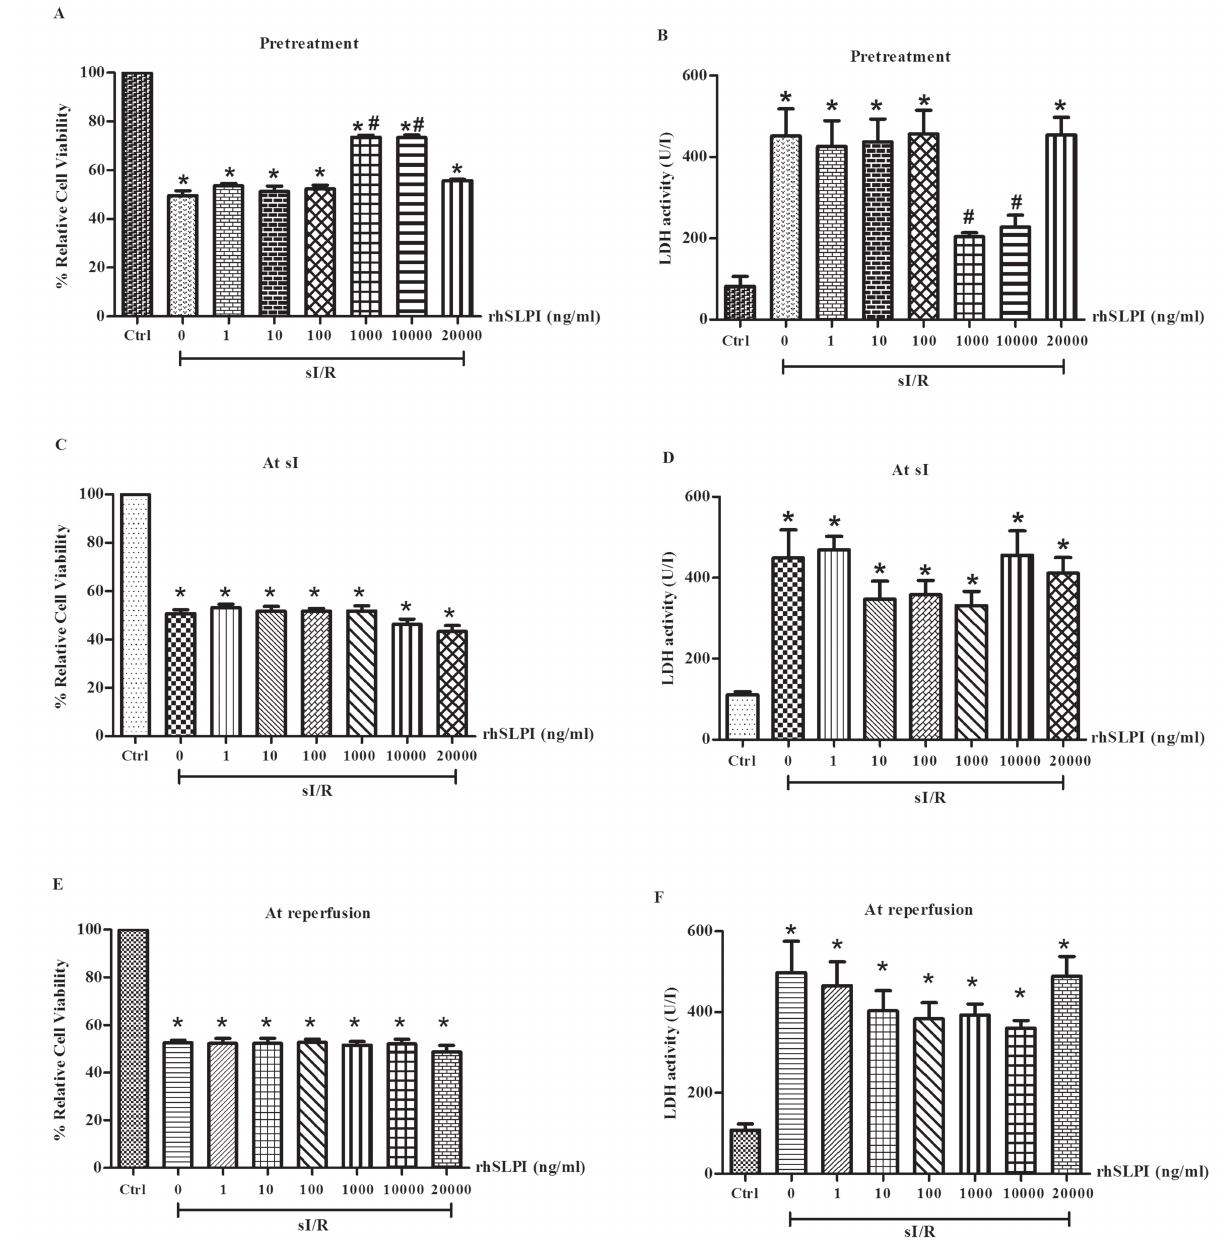
Figure 5: Determination of the effects of recombinant human SLPI (rhSLPI) on H9c2 cells subjected sI/R. The H9c2 cells were divided into three groups, including treatment of rhSLPI 24 h prior to ischemia or pre-treatment, rhSLPI treatment at the onset of ischemia, and rhSLPI treatment at the onset of reperfusion. After treatment, all groups were subjected to 40 min sI followed by 24 h reperfusion. The percentage of cell viability (5A,5C,5E) and released LDH activity of all groups (5B,5D,5F) were determined. Each bar graph represents means ± S.E.M for each of the six experiments. * p < 0.05 vs control group (ANOVA), # p < 0.05 vs sI